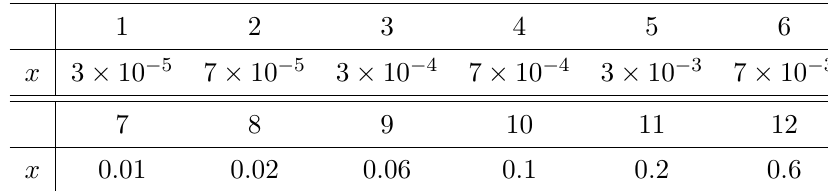
Table 3 . The x values selected for the calculation of the uncertainties of R f .